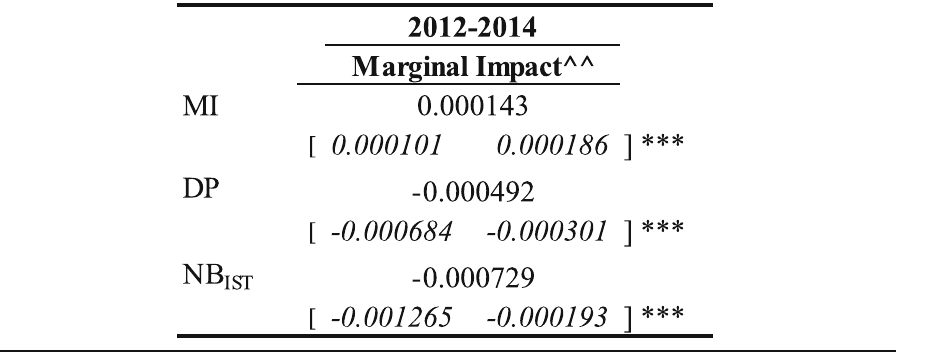
^Impact of an increase of 1000 Euro/farm ^^Assuming that farmers pay contributions proportional to their income to cover 35% of the overall indemnification cost (IIP) Source: Own elaborations on Italian FADN data